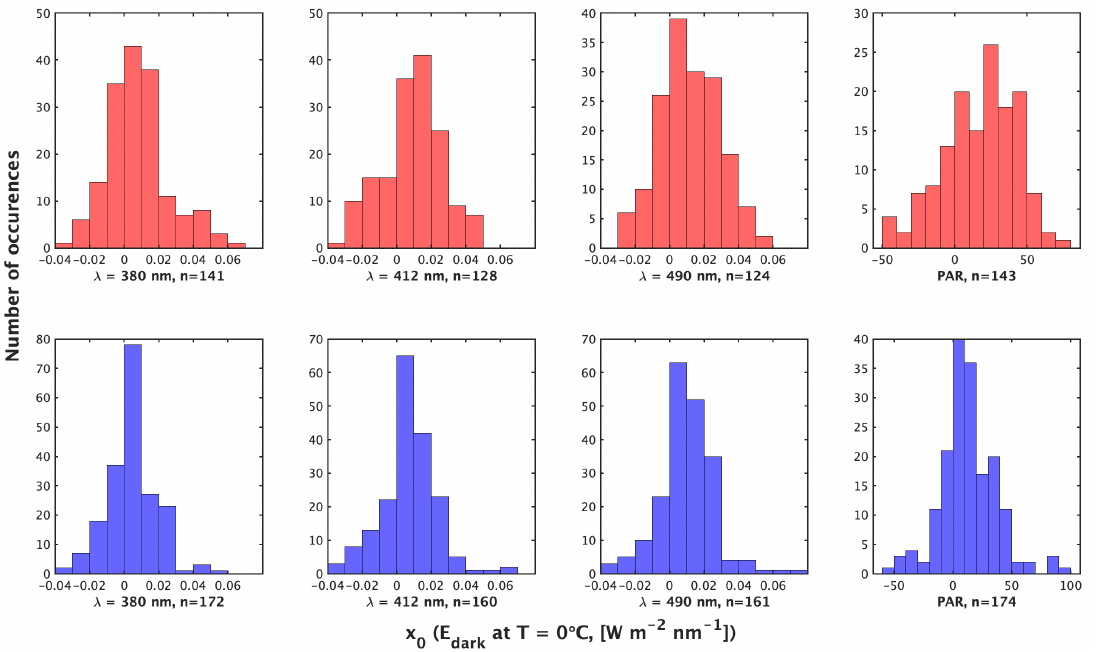
Figure 3. Histograms of the value of x 0 (W m − 2 nm − 1 or µ mol photons m − 2 s − 1 ) by the night method ( top ) and day method ( bottom ) for ( left to right ) λ = 380 nm, 412 nm, 490 nm and PAR. x 0 is the value reported by the irradiance sensor in the dark at T s = 0 ◦